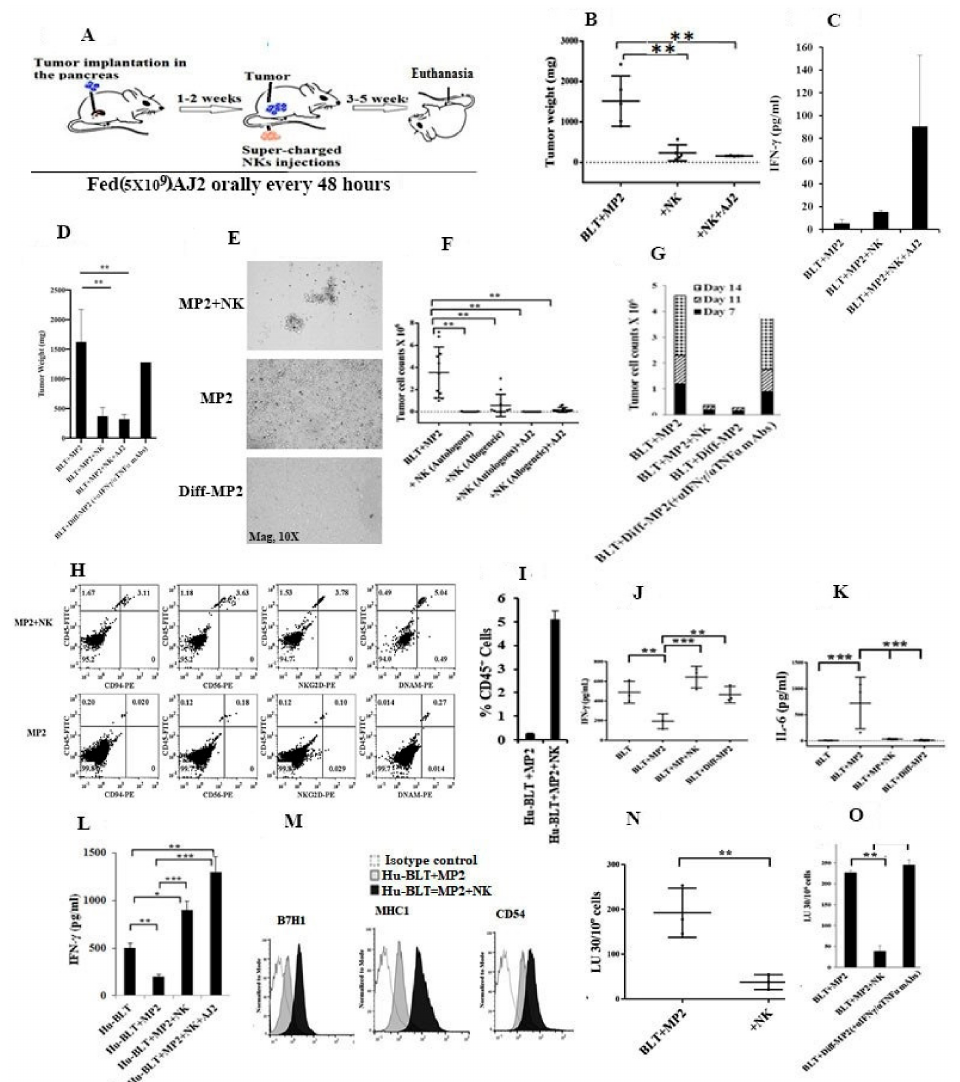
Figure 4. Single injection of super-charged NK-cells with / without feeding with AJ2 inhibited tumor growth due to di ff erentiation of tumors in hu-BLT mice. Implantation of tumor cells in the pancreas and tail vein injection of super-charged NK cells and feeding with AJ2 (5 × 10 9 ) were carried out as depicted in the figure ( A ), and disease progression was monitored. Mice were sacrificed, and pancreatic tumors were harvested and weighed ( n = 4 / each experimental condition) ( B ). Implantation of tumor cells in the pancreas and tail vein injection of super-charged NK cells were carried out as depicted in Figure 4A, and at the time of sacrifice mice were bled and the levels of IFN- γ in the serum were determined using multiplex array ( n = 3) ( C ). Procedures were carried out as depicted in Figure 4A, Figure S3A and Figure S4C before pancreatic tumors were harvested and weighed ( n = 3) ( D ). Upon sacrifice, pancreatic tumors were harvested and single cell suspensions were prepared as described in Materials and Methods. The same numbers of pancreatic tumor cells from each mouse were cultured, and the pictures of cultured tumors were taken on day 7. One of the four representative